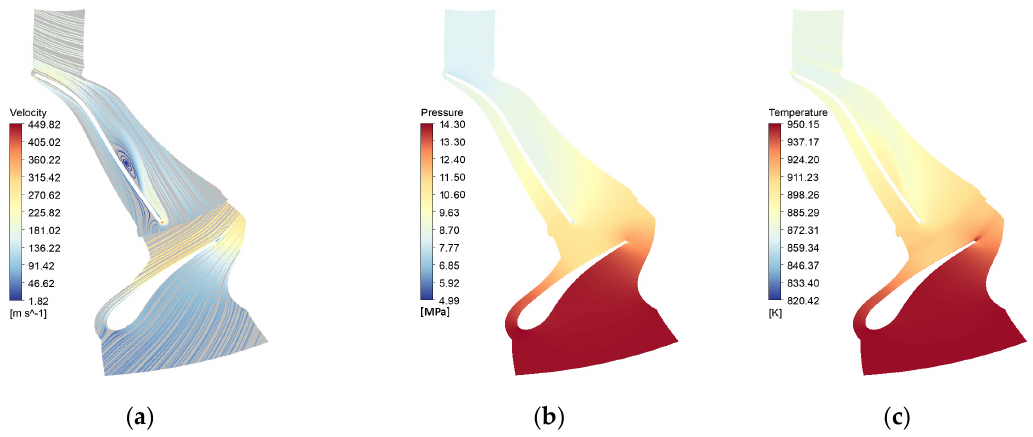
Figure 6. Key parameter distributions of 50% blade height section of Case A: ( a ) limiting streamline; ( b ) pressure distribution; ( c ) temperature distribution.